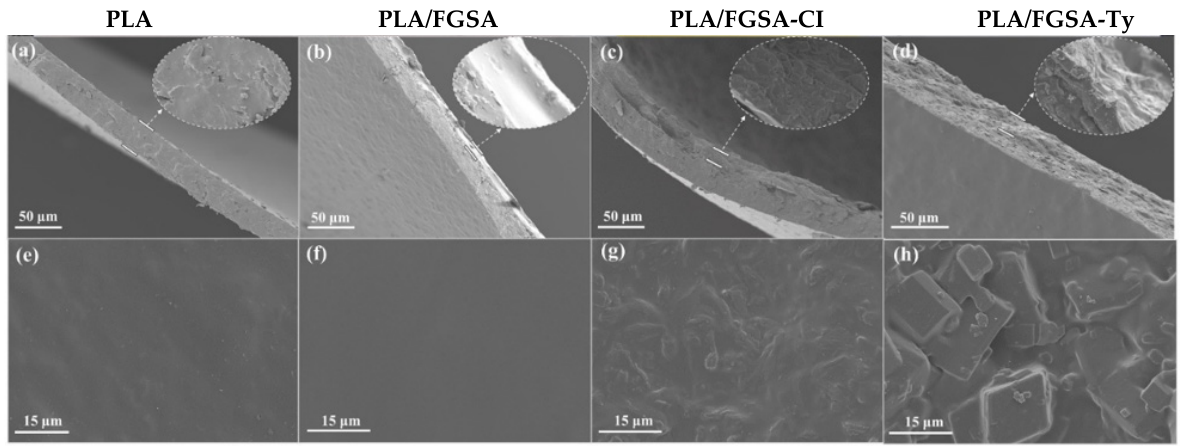
Figure 2. Scanning electron micrographs of cross-section ( a − d ) and surface ( e − h ) of films (PLA, PLA/FGSA, PLA/FGSA-CI, and PLA/FGSA-Ty) .